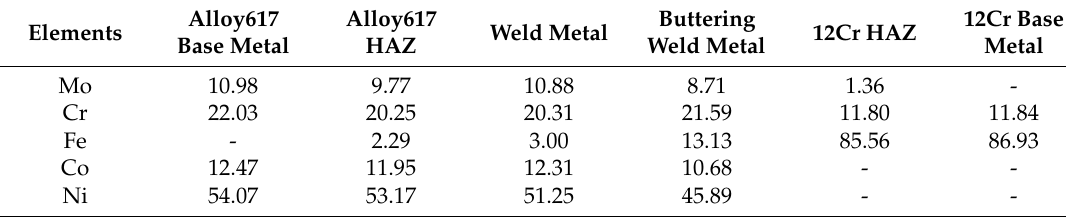
Table 4. Chemical compositions analysis results prior to PWHT (wt. %).